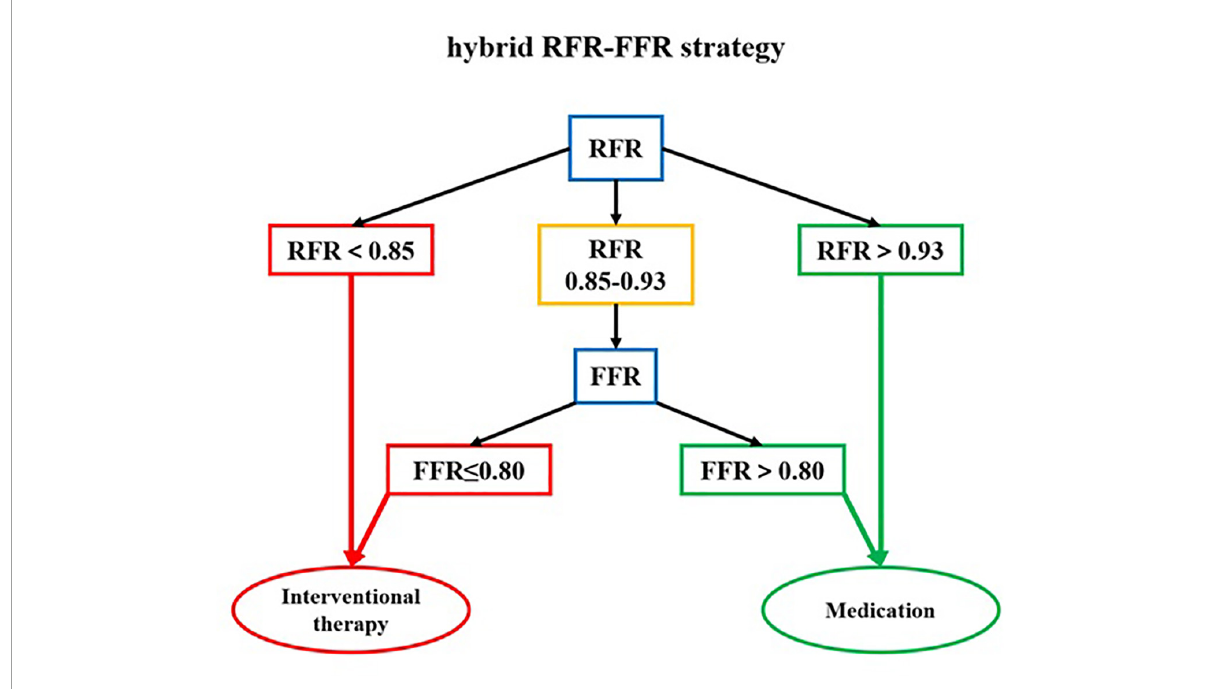
FIGURE4 The diagnosis flow chart of the hybrid RFR-FFR strategy. RFR, resting full-cycle ratio; FFR, fractional flow